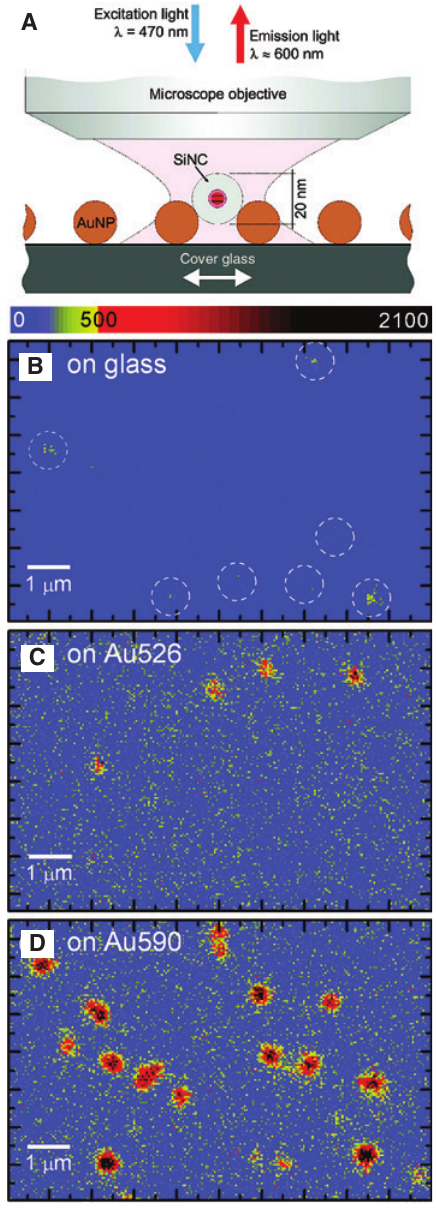
Figure 12: Layer-by-layer deposition of AuNPs and silica-coated CdSe